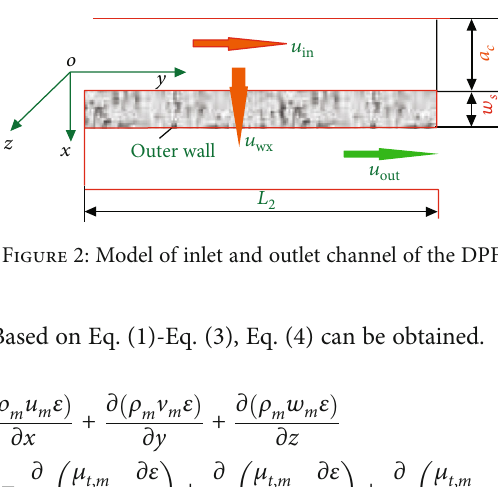
Figure 1: Structure of the diesel particulate fi lter. Note: A, B, C, and D: the relative position of each calculation section; 1: inlet pipe; 2: expansion pipe; 3: fi lter; 4: shrink pipe; 5: exhaust pipe.